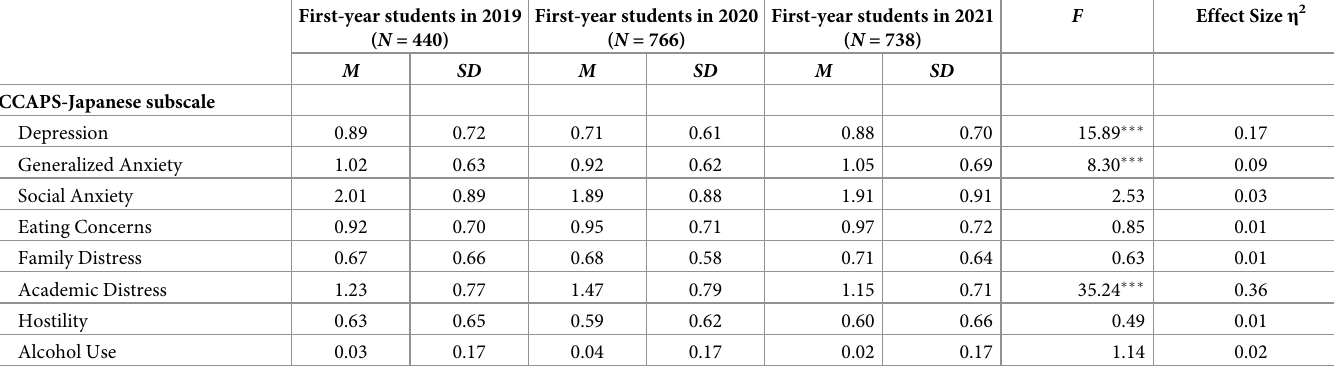
Table 2. Results of comparing the CCAPS-Japanese subscales for 2019, 2020, and 2021 first-year